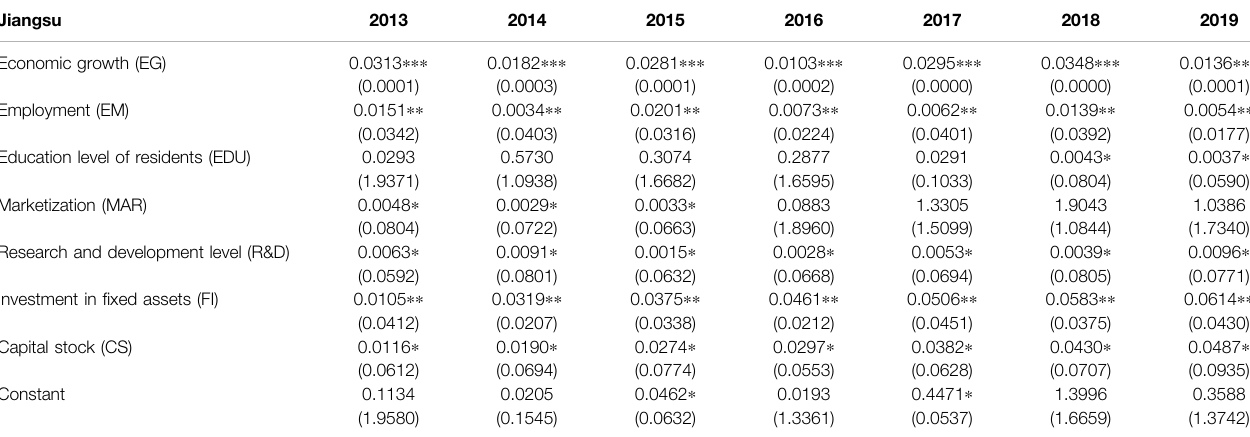
TABLE 7 | Driving force of Jiangsu health tourism industry convergence. Jiangsu